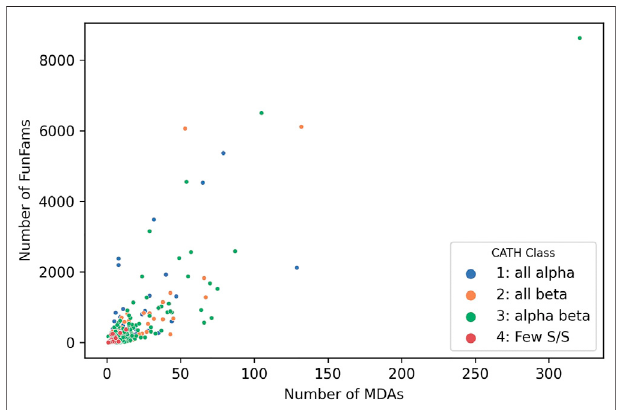
FIGURE 8 | Number of MDAs vs Number of sequence subfamilies (FunFams) for each SuperFamily in CATH